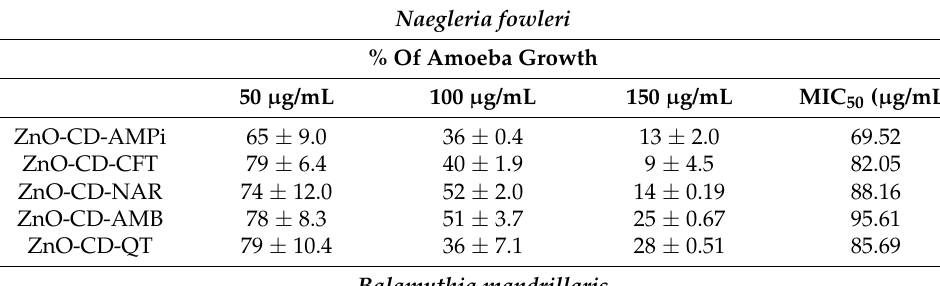
Table 1. MIC 50 of the examined compounds against N. fowleri and B. mandrillaris . The minimum inhibitory concentration was determined for compounds against N. fowleri and B. mandrillaris . The re- sults are expressed as percentage (%) of amoeba growth, with untreated amoeba (control) exhibiting 100% growth. Concentrations of 50 µ g/mL, 100 µ g/mL, and 150 µ g/mL were tested against N. fowleri and B. mandrillaris